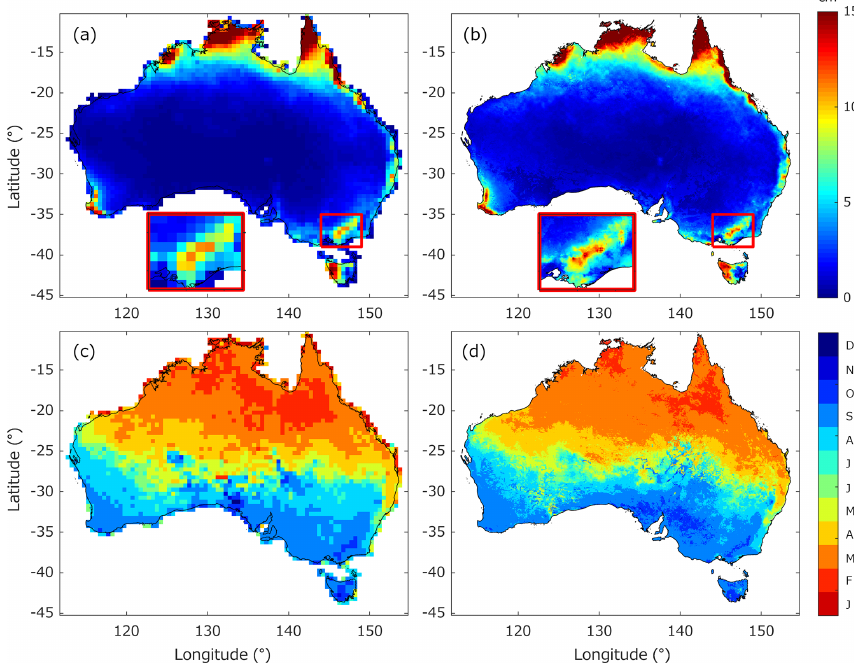
Figure 5. Annual amplitude (a, b) and phase (c, d) of the TWS estimates computed from CABLE 0.5 ◦ (a, c) and CABLE 0.05 ◦ (b, d) . The insets in (a) and (b) show details in southeastern Australia. The phase exhibits the timing when TWS reaches the maximum value (with respect to the beginning of the year). The unit of the phase is a calendar month, e.g., January (J) or December (D).